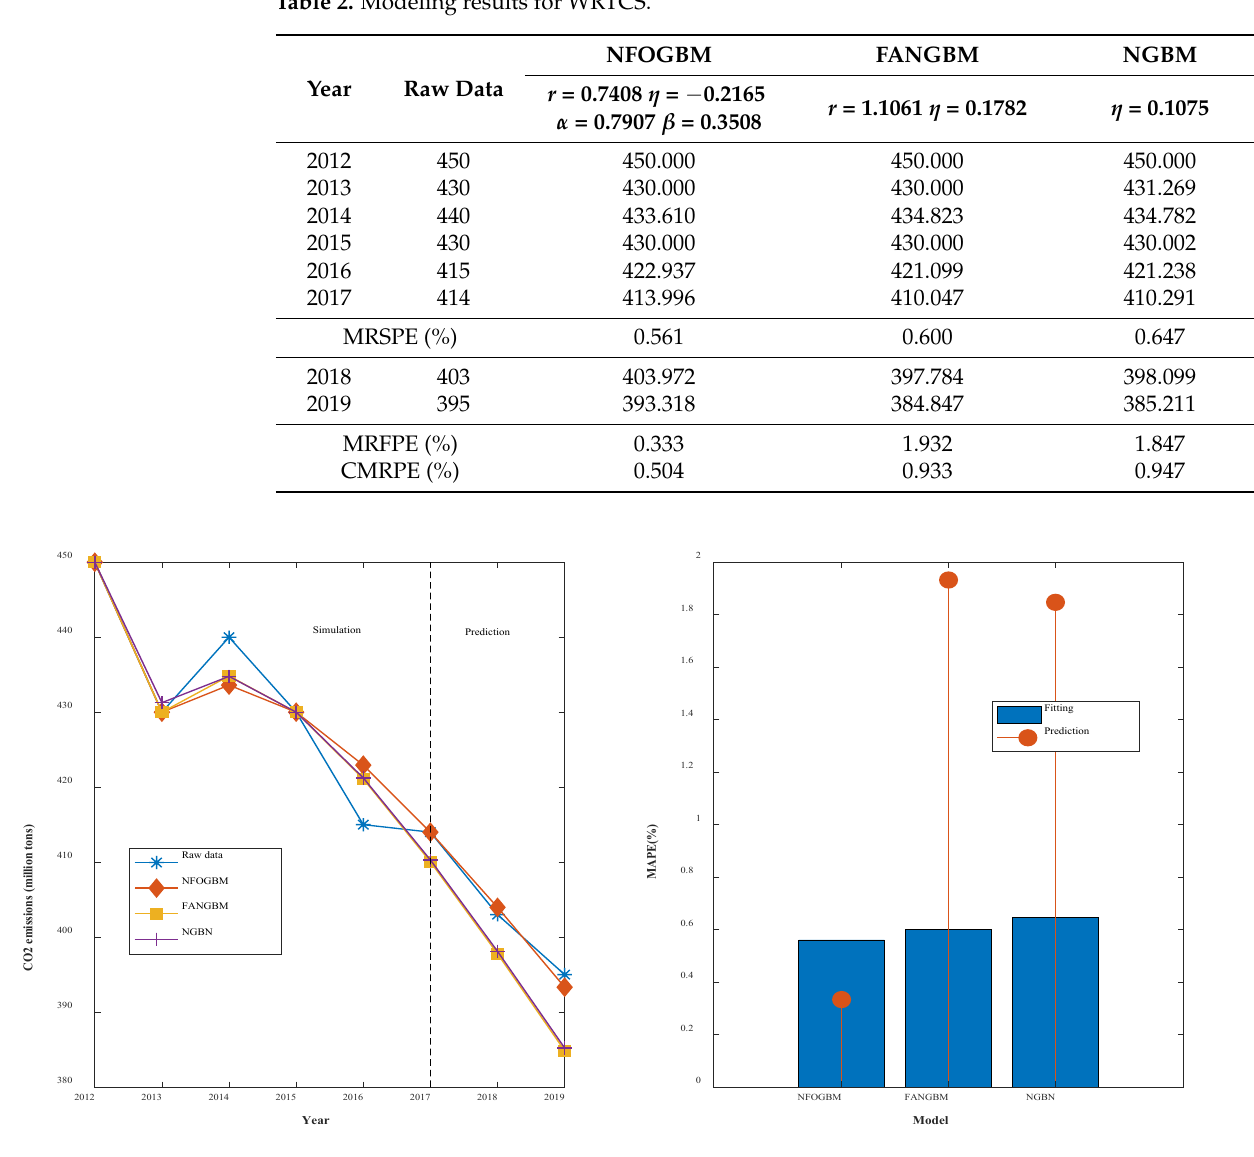
Table 2. Modeling results for WRTCS.